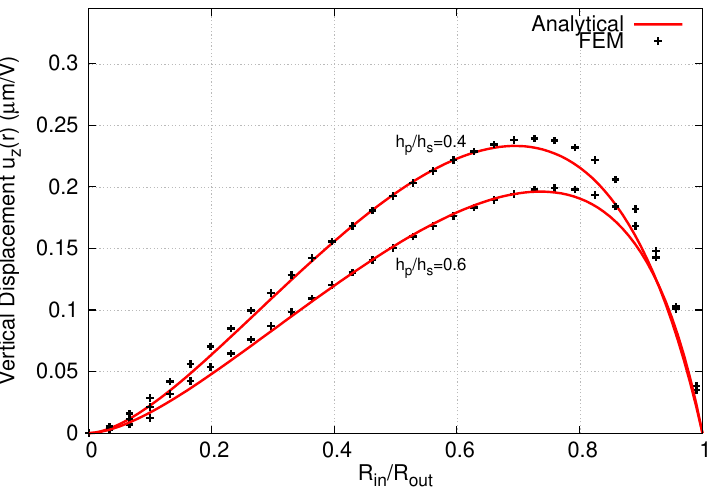
Figure 11. Prediction of maximum deflection at the center of the plate as a function of the radius ratio between the PZT layer and shim layer. The comparison between analytical and current FEM model for different thickness ratios h p / h s shows a consistent trend in the variation of maximum displacement with the radius